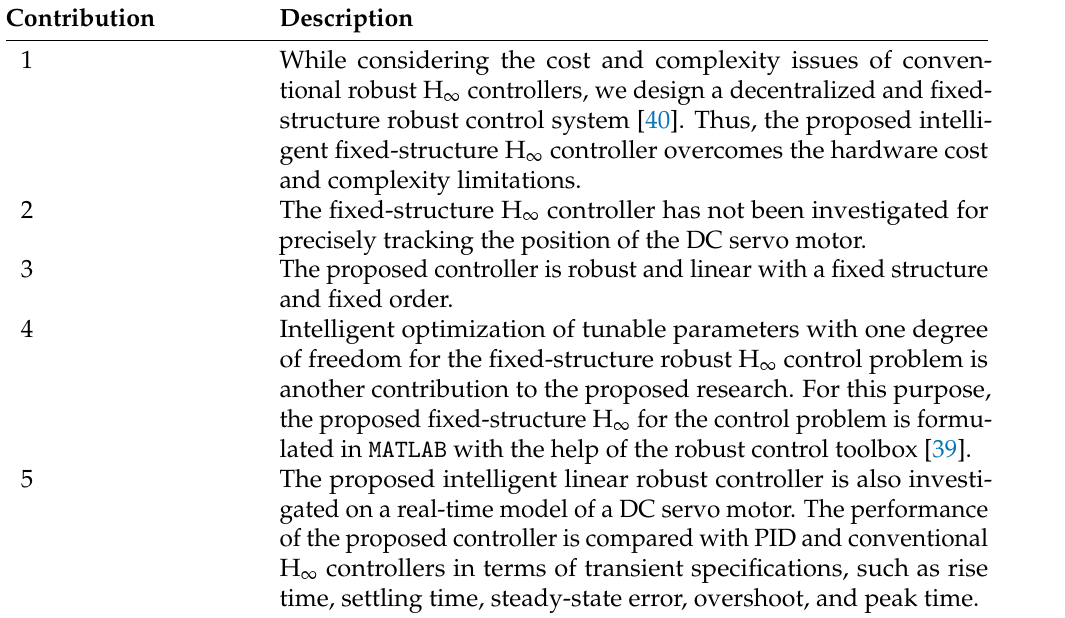
Table 2. Contributions of the present